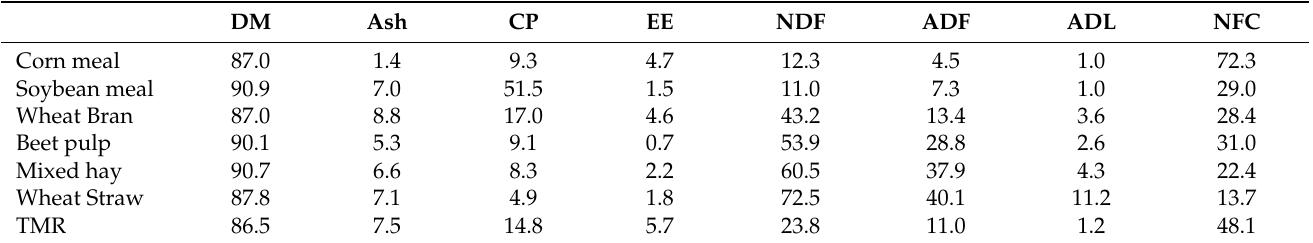
Table 1. Composition of TMR and feeds